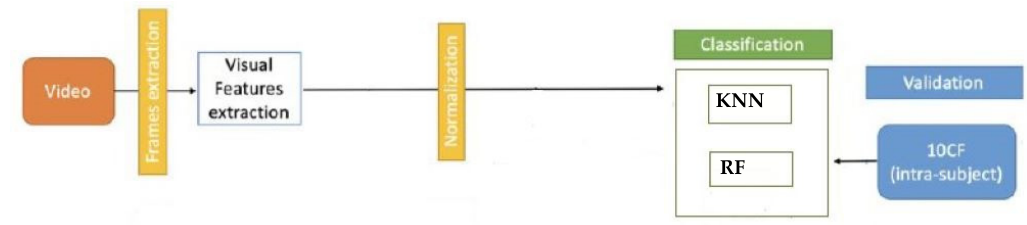
Figure 3. Data analysis.